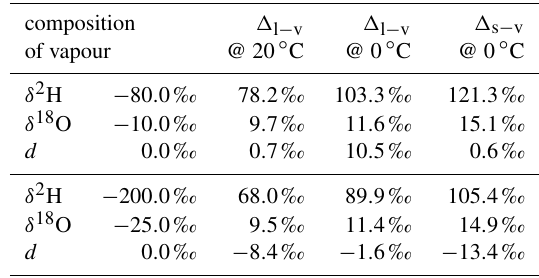
Table 1. Calculated difference in isotopic composition of liquid ( (cid:49) l − v ) or solid ( (cid:49) s − v ) in equilibrium with a vapour of different isotopic composition. The fractionation factors of Majoube (1971b) are used for the